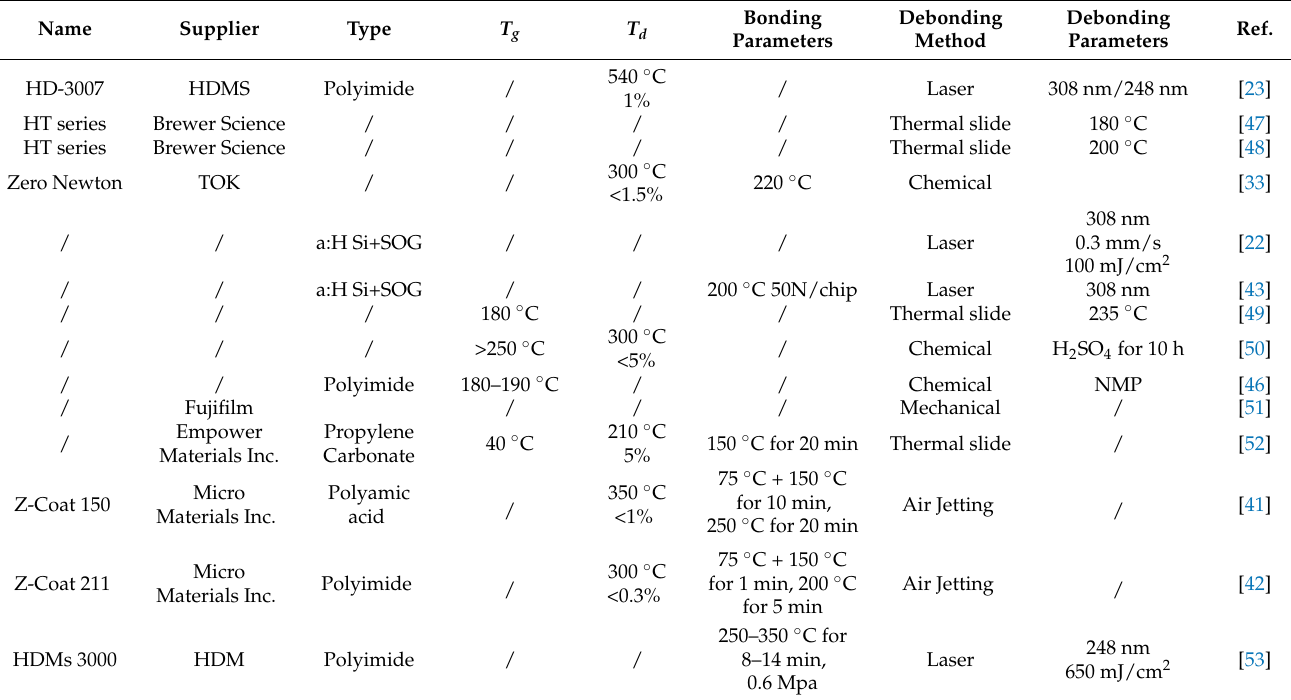
Figure 2. Main flow of temporary bonding/debonding. F represents possible external force assisting debonding. Table 2. Summary of properties of various temporary bonding